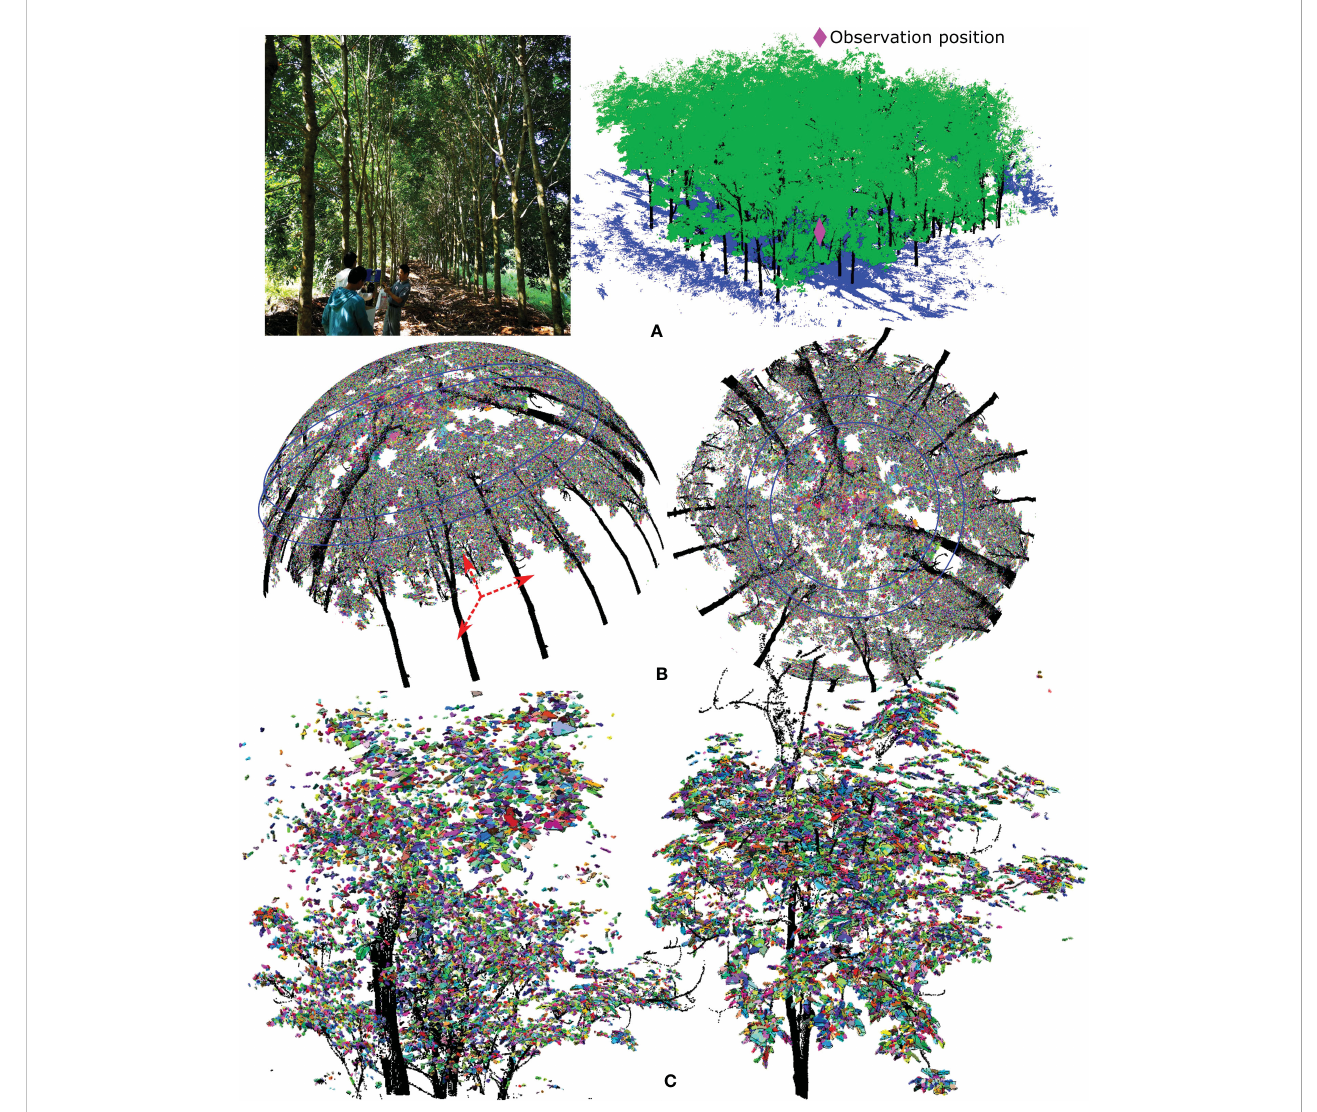
FIGURE 6 shows the volume-based gap fraction calculation for a rubber tree plot. (A) The images and scanned points for a lush forest plot of rubber tree clone PR 107 with interlacing branches and foliage clumps. (B) With the ground centre of the plot as the projection centre for the spherical projection, the scanned points after wood – leaf segmentation and individual leaf extraction were transformed to a synthetic hemispherical photo (HP) to assess canopy openness, i.e., to estimate the HP-based gap fraction. (C) Magni fi cation of partial tree crowns with identi fi ed individual leaves highlighted in different colours and enveloped by translucent hexagonal prisms using our